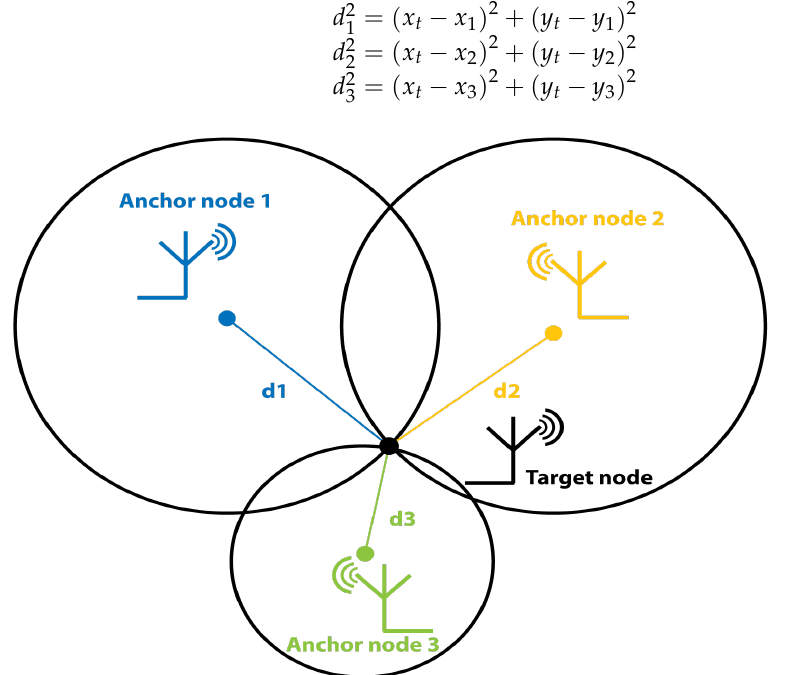
Figure 14. Trilateration